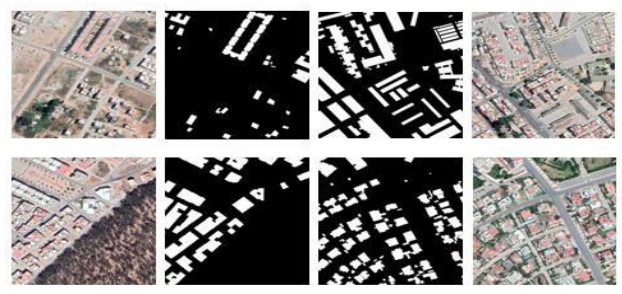
Fig. 7 : Ground-truth masks and satellite images from our Dataset.